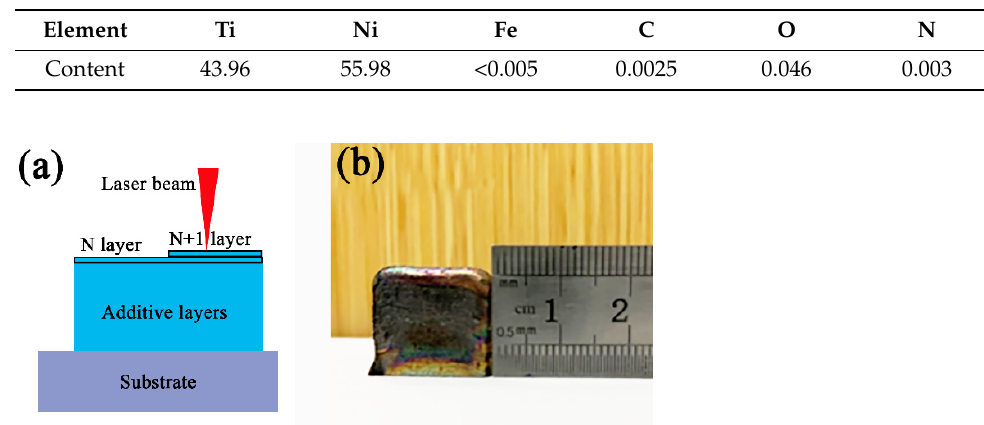
Figure 1. ( a ) Schematic diagram of the laser solid forming process; ( b ) Laser solid forming blocky sample of TiNi alloy. Table 1. Chemical composition of TiNi pre-alloyed powder (wt.%).